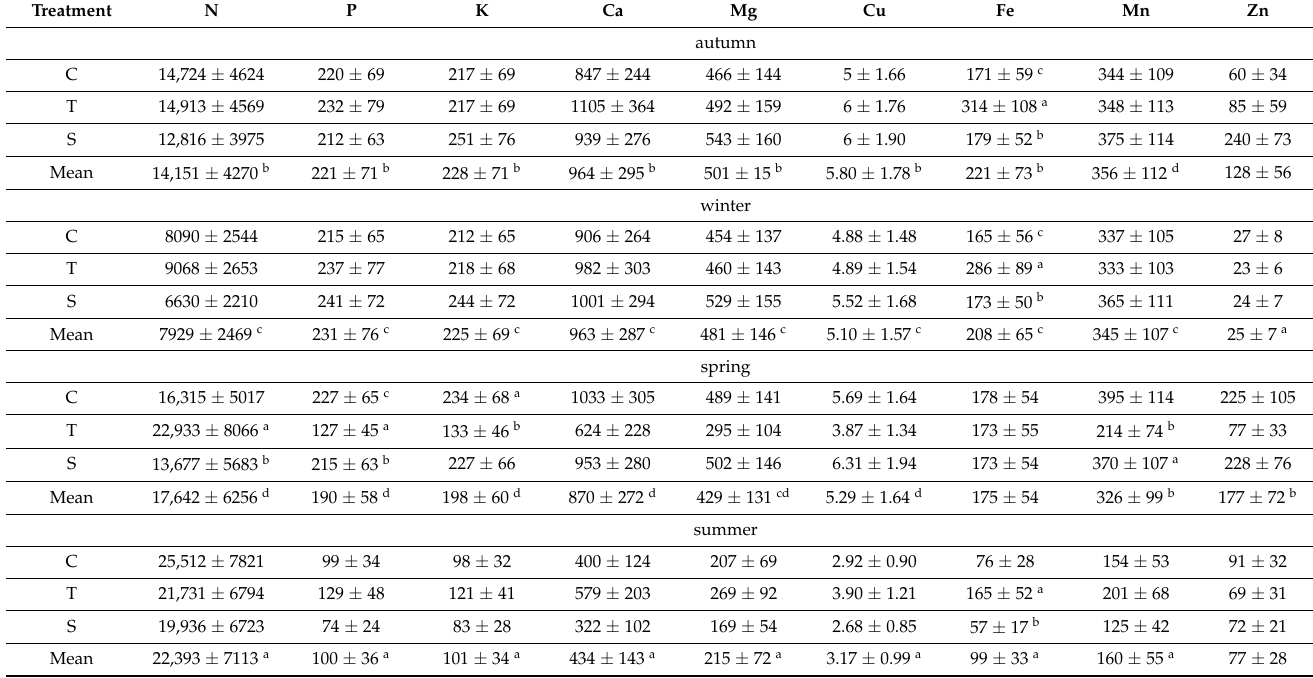
Table 1. Mean seasonal forest floor nutrients concentration (mean ± SD) expressed as mg · kg − 1 of three replicates for three thinning treatments in period (16 October until 17 September). (C: Control, T: Traditional. S: Selective. N: Nitrogen, P: Phosphate, K: Potassium, Ca: Calcium, Mg: Magnesium, Cu: Copper, Fe: Iron, Mn: Manganese, Zn: